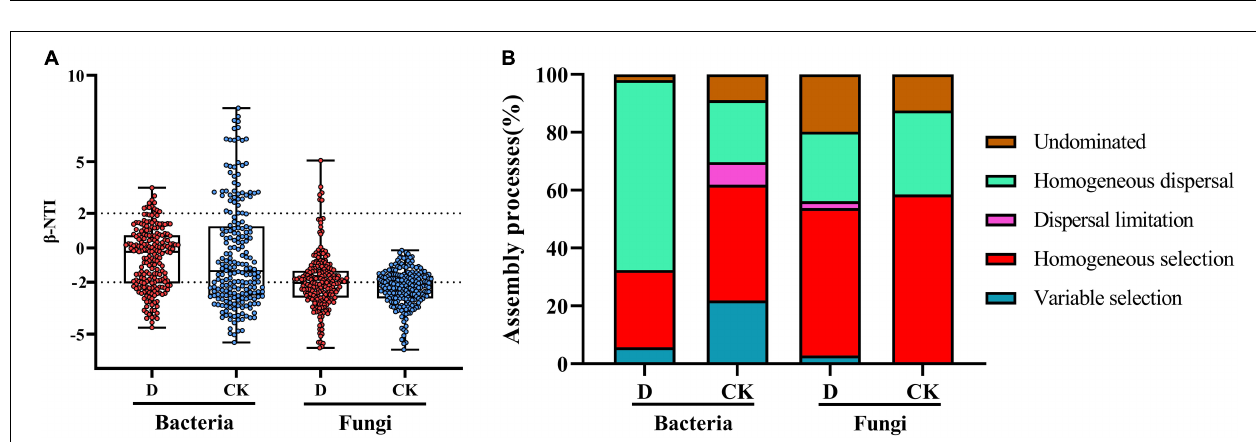
FIGURE 6 | Distance-based redundancy analysis (dbRDA) of environmental factors with (A) bacterial and (B) fungal taxa in the garlic cropping obstacle soil (D) and healthy control soil (CK).